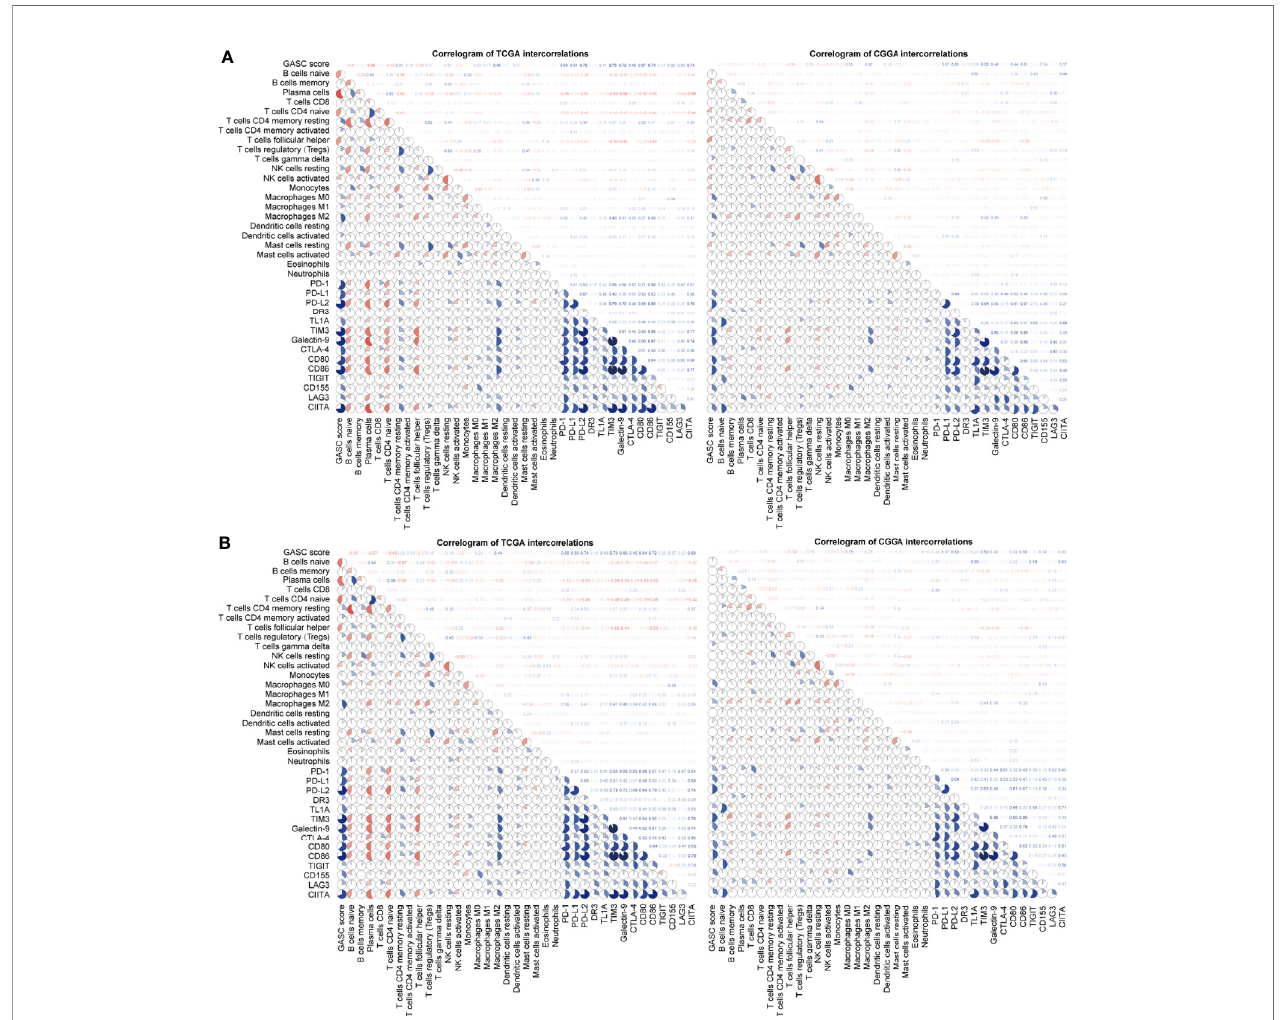
FIGURE 9 | Correlogram of GASC score, immune cells, and expression of ICP intercorrelation. (A) Correlogram of data in all glioma population. (B) Correlogram of data in high-grade glioma